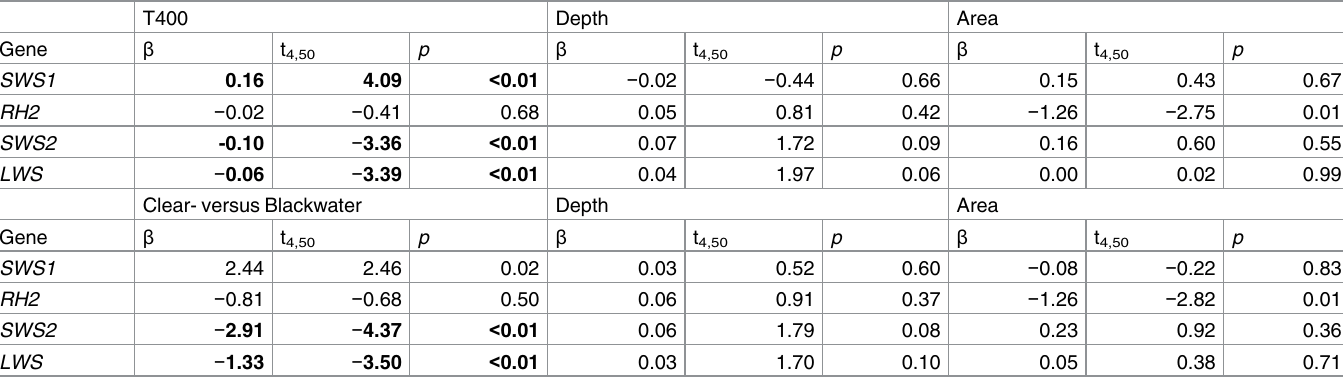
Table 2. General linear model results for genotype–environment association